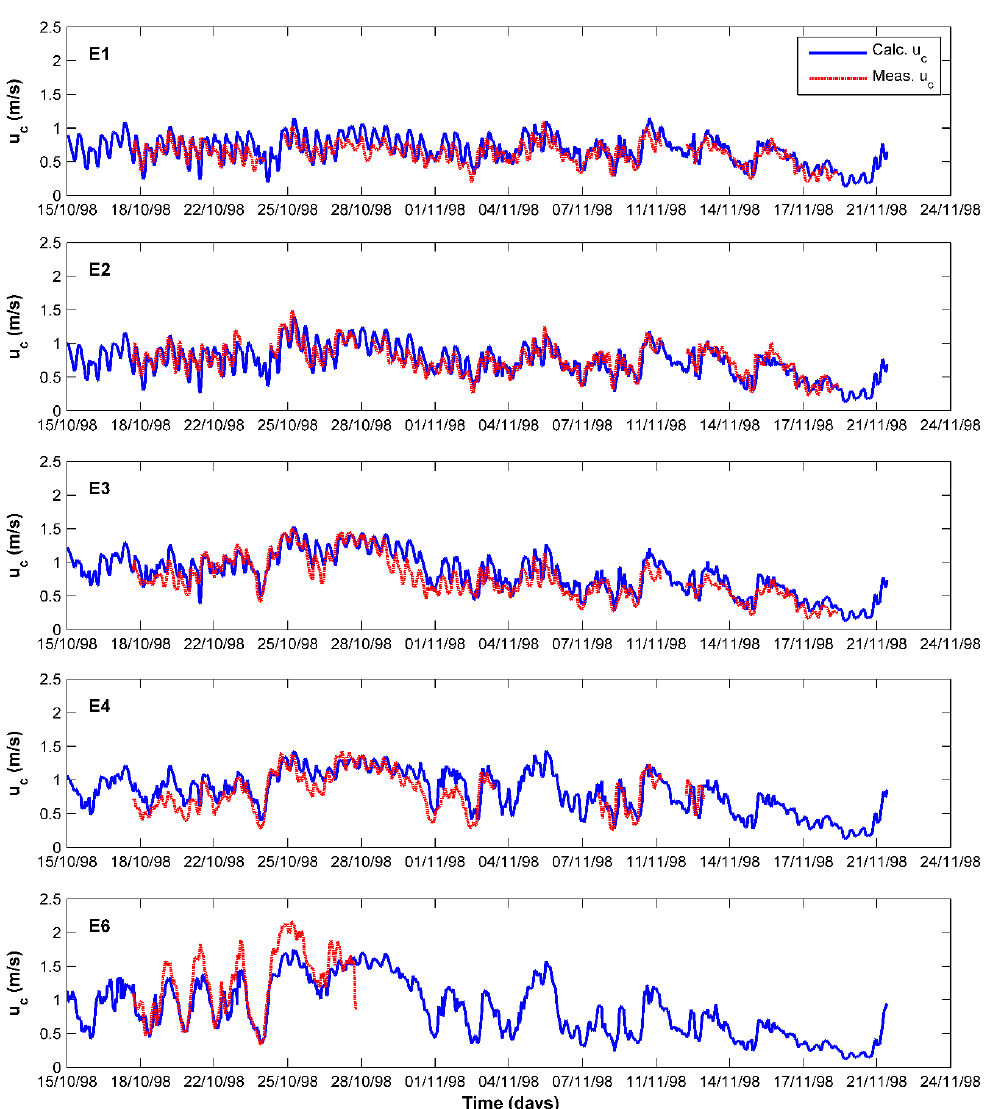
Figure 7. Calculated and measured peak onshore orbital velocity at Egmond Beach.